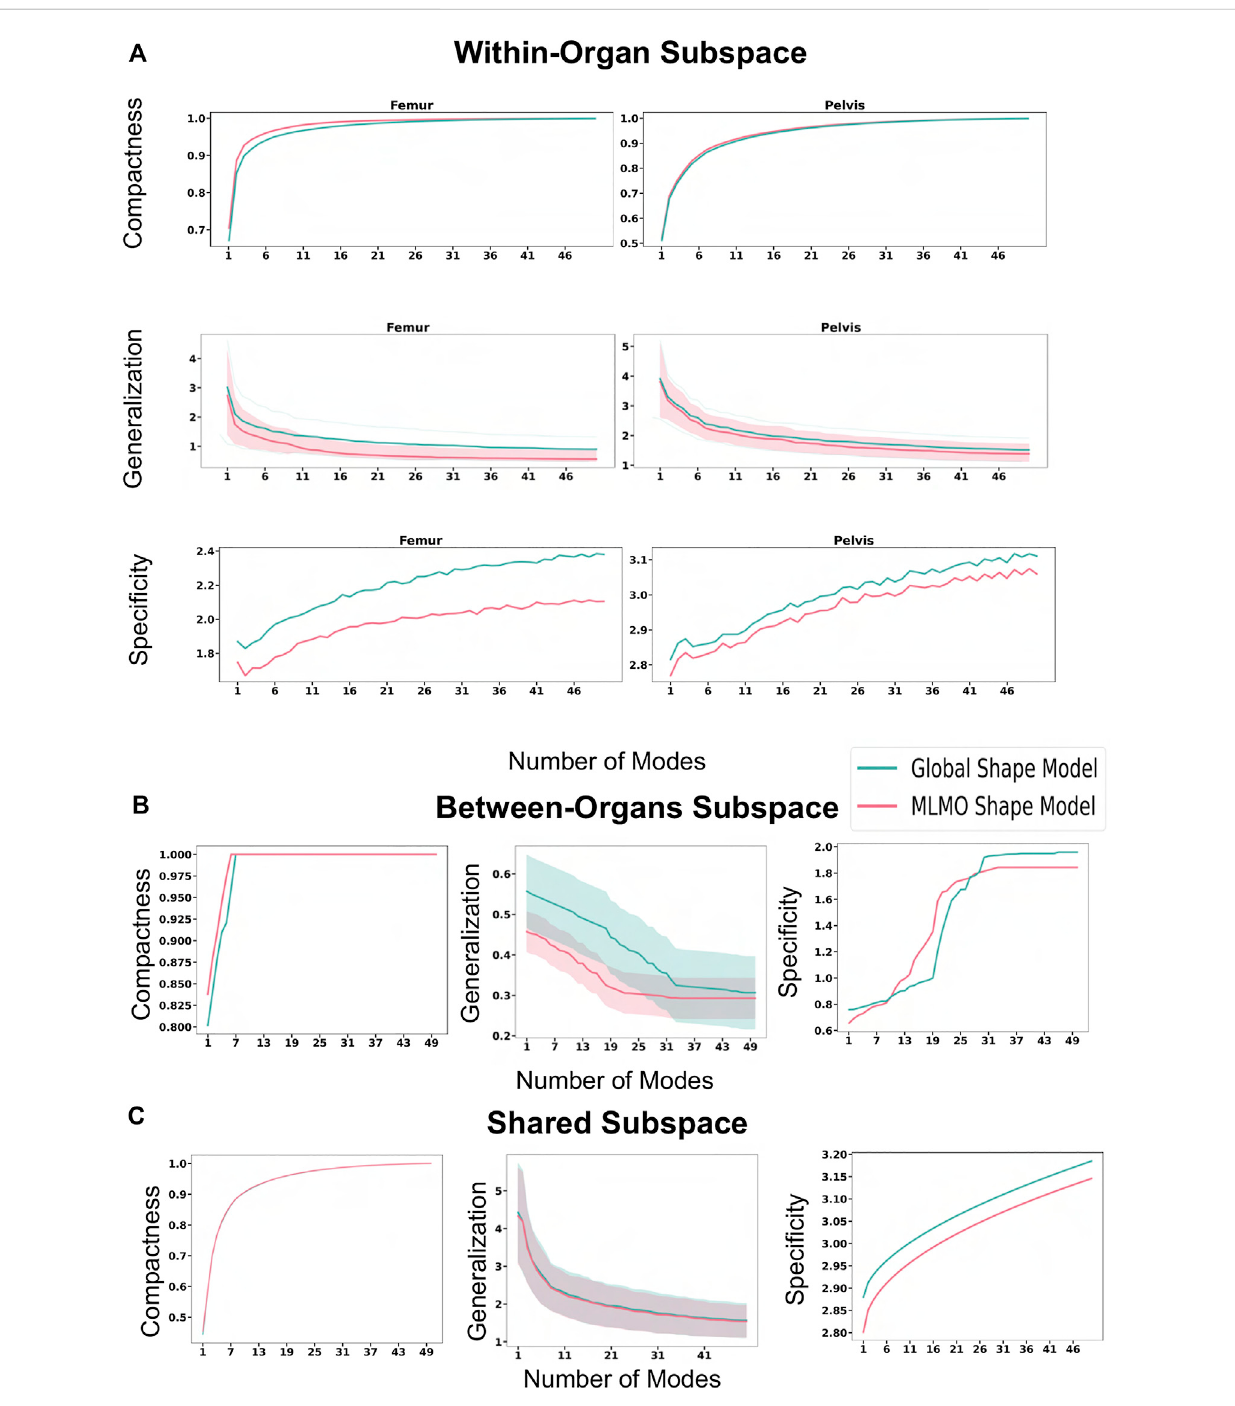
FIGURE 13 QuantitativeEvaluationmetrics(compactness,generalization(in mm ),andspeci fi city(in mm ))forthehipjointdatasetcomputedin (A) within-organ (B) between-organs (C) shared